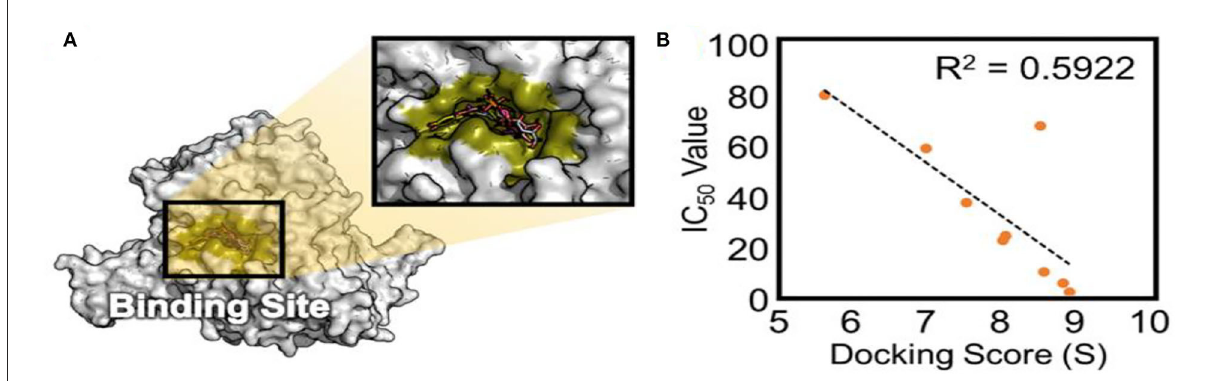
FIGURE3 The active site of XO (A) and experimentally determined IC 50 values (B) of different phenolic compounds shown concerning their ranking by docking score. XO, Xanthine oxidase.